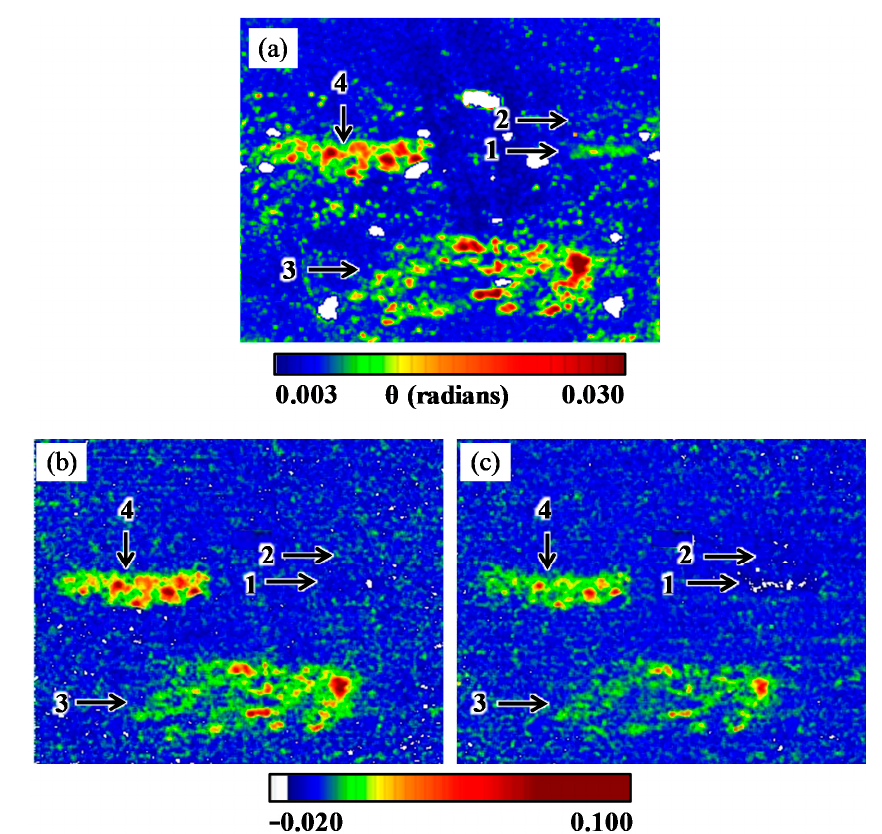
Figure 6. ( a ) Spectral angle mapper (SAM) algorithm rule map of the brown alluvial soil study area emphasizing changes on the surface resulting from the dispersion of 50 g m -2 dust_1 (region 1), 250 g m -2 dust_2 (region 2), 250 g m -2 dust_3 (region 3) and 250 g m -2 dune sand (region 4); a larger angle ( θ ) indicates bigger changes on the surface. Δ SQCMI ( b ) and Δ SCI ( c ) images; blue color in (b) and (c) represents Δ SQCMI and Δ SCI ≈ 0, i.e., no mineralogical changes. The non-homogeneity of θ , Δ SQCMI and Δ SCI values within a region, resulting from the dispersion procedure, emphasizes the sensitivity for detecting local mineralogical changes in the soil surface.